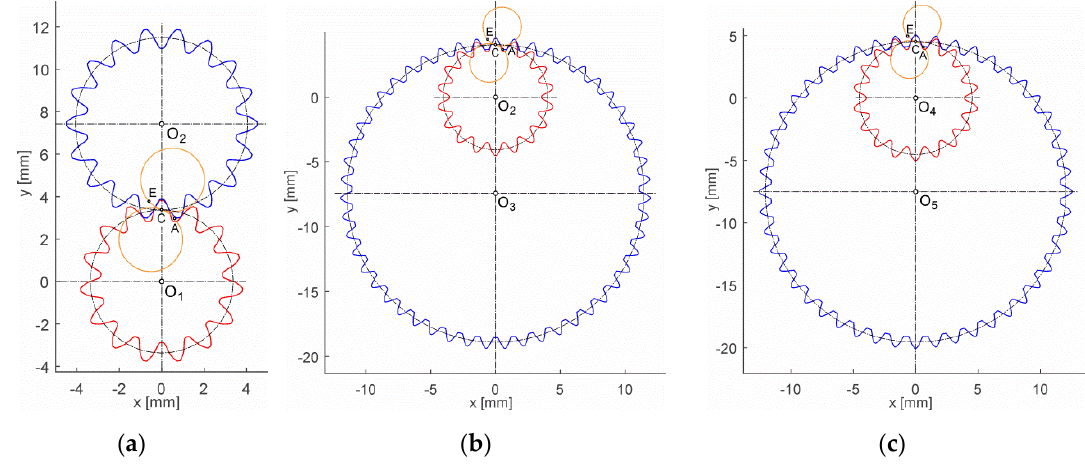
Figure 7. Geometric models of the gear pairs with convex-concave teeth flanks: ( a ) gear pair 1-2, ( b ) gear pair 2-3, and ( c ) gear pair 4-5.